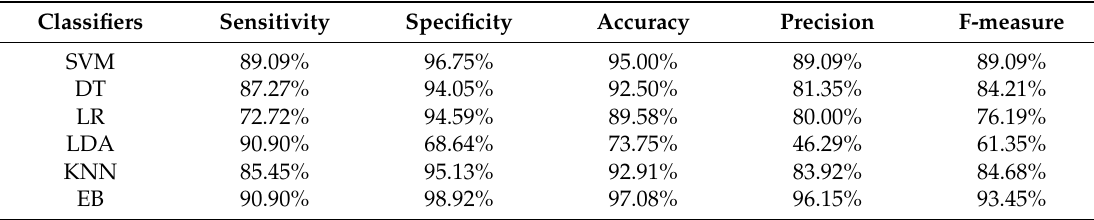
Table 3. Classification results based on hybrid simulated annealing coupling with different classifiers.